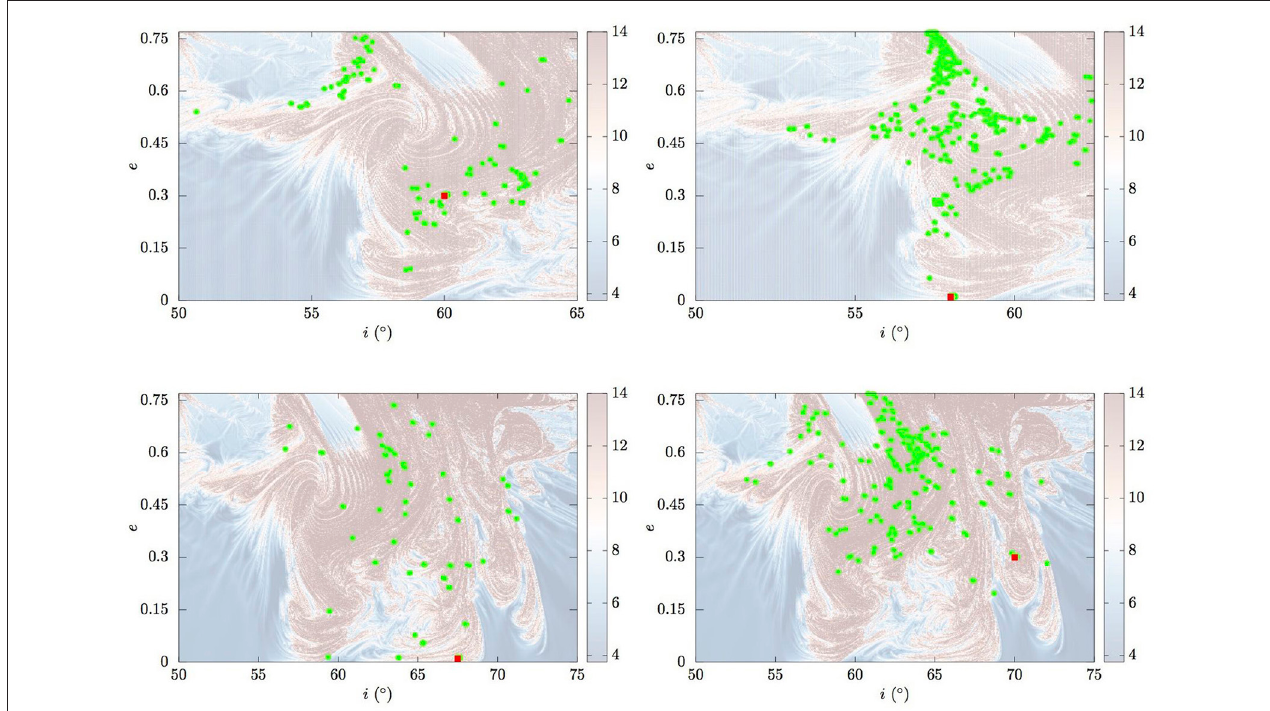
FIGURE 10 | Diffusive scenarios illustrating transport scenarios within the hyperbolic web in the regime of large perturbative parameters and strong resonances overlap. The red spots indicate the initial condition where the ensemble of initial conditions are defined. Points of the orbits that return sufficiently close to the section (on which the FLIs appear as a background) are depicted with a green point. See text for comments.